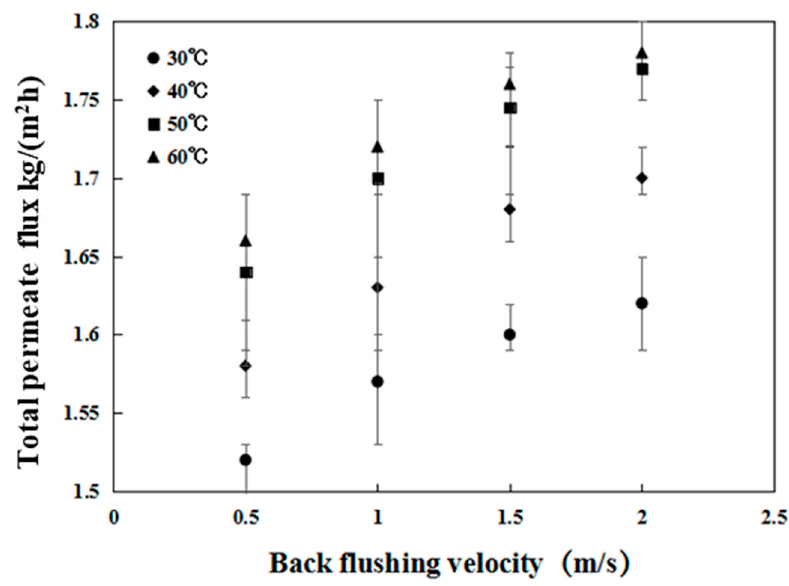
Figure 10. Influence of the backflushing velocity and flushing water temperature on the total permeate flux. (Feed: NaCl (15 wt.%)/ethyl acetate (4.5 wt.%)/water).